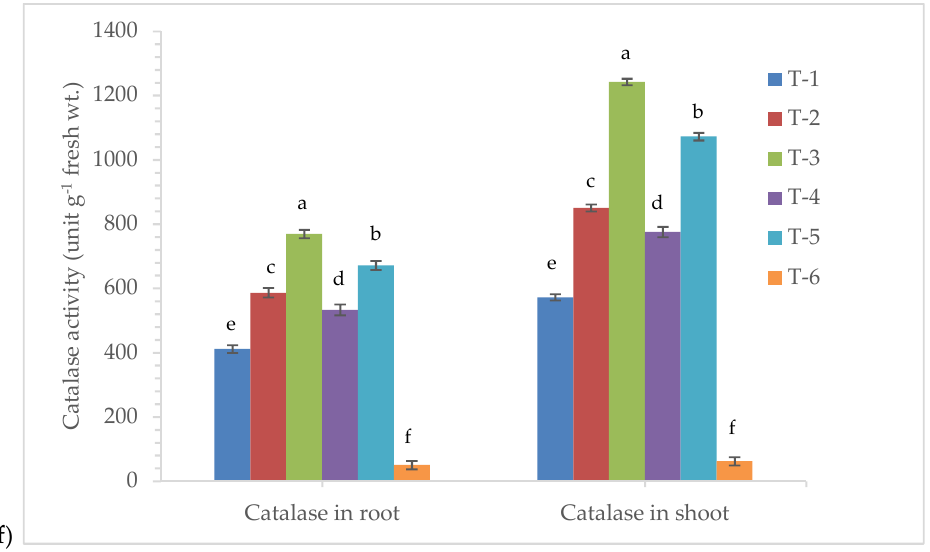
Figure 5. Effects of seed bio-priming and other treatments on activity of antioxidant enzymes ( a ) phenylalanine ammonia lyase (PAL), ( b ) ascorbate peroxidase (APx), ( c ) peroxidase (POx), ( d ) chitinase, ( e ) superoxide dismutase (SOD), and ( f ) catalase (CAT) activity in maize root and shoot at 7 DAPI under nethouse condition. Treatments were: T 1 -plants inoculated with R. solani alone; T 2 - R. solani + seed bio-primed with P. aeruginosa MF-30; T 3 - R. solani + seed bio-primed with P. aeruginosa MF-30 + foliar spray of MF-30; T 4 - R. solani + foliar spray of culture filtrate of MF-30; T 5 - R. solani + seed bio-primed with P. aeruginosa MF-30 + foliar spray of culture filtrate of MF-30; T 6 -Control (untreated). Data are mean ± SEM ( n = 5).